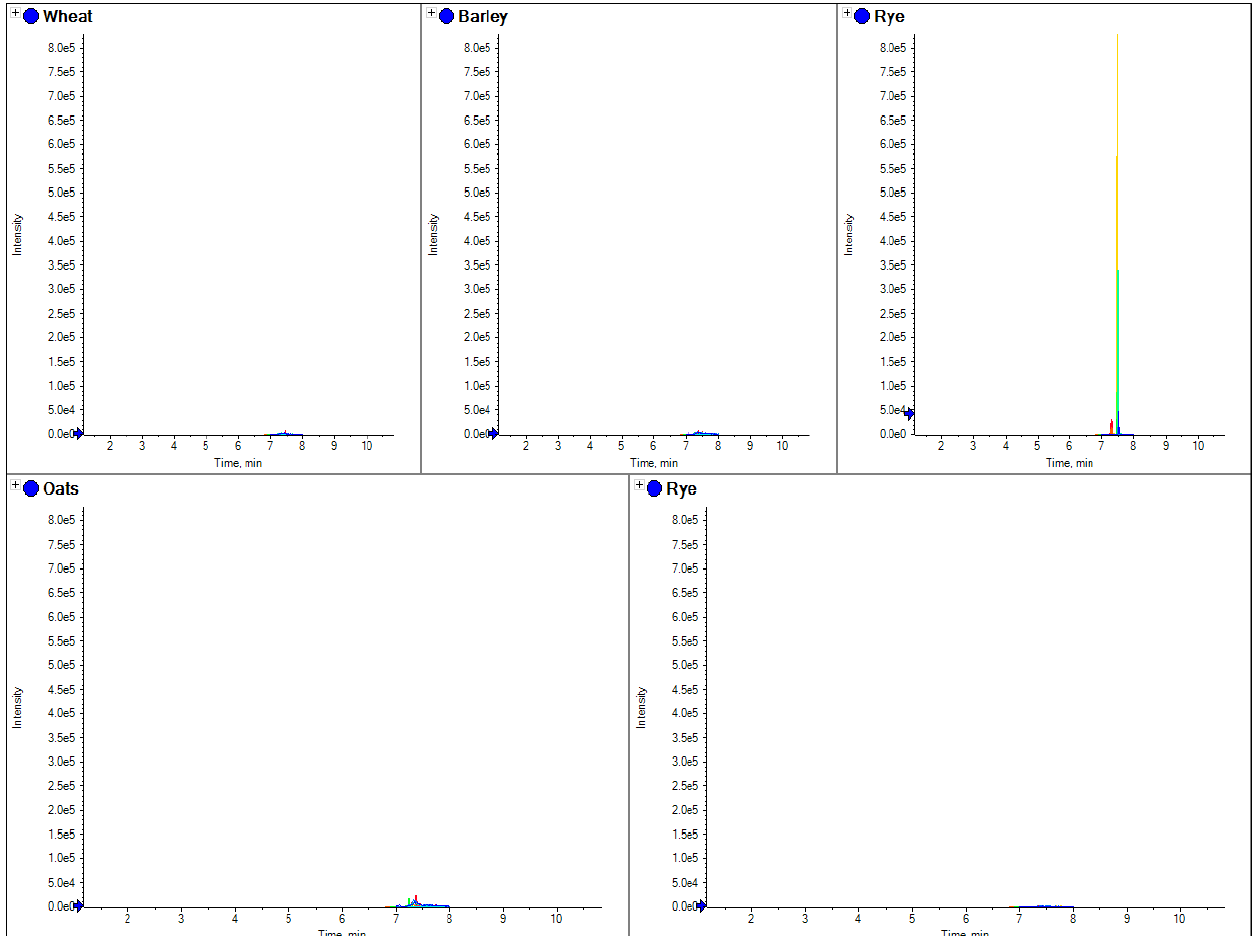
Figure 5. The comparison of separate extracts from barley, wheat, rye and oats flour. Here the overlaid chromatograms for rye marker peptides (obtained from the theoretical digestion of secalin) have been shown for flour extracts for each